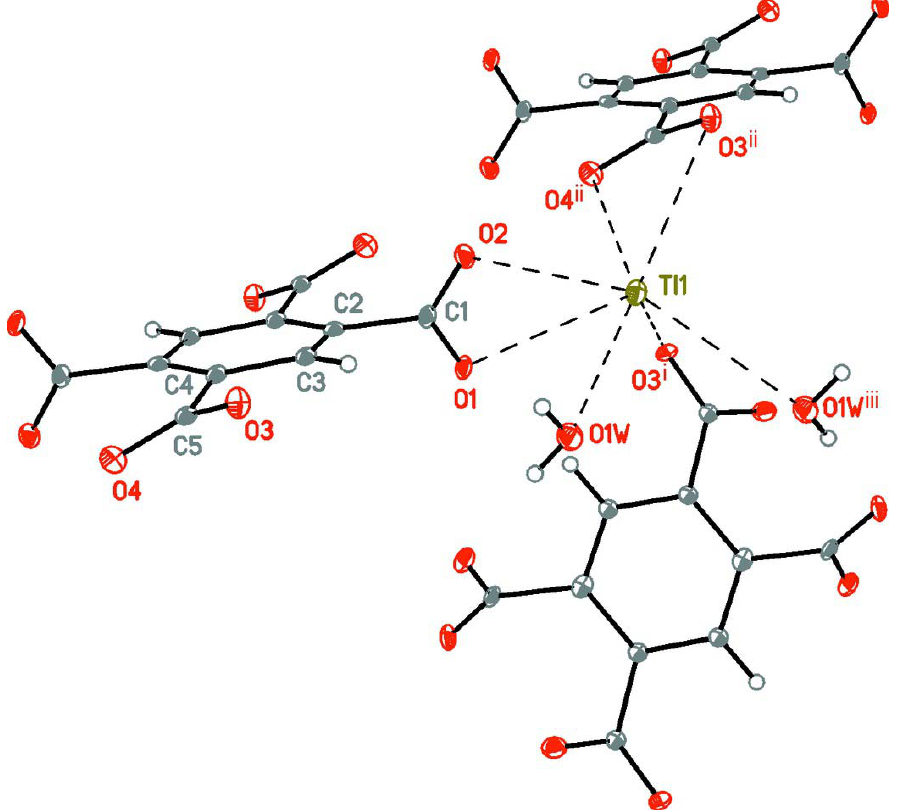
Coordination environment around the Tl atom in the title compound, showing an empty space on one side of the atom Tl1. Displacement ellipsoids are drawn at the 50% probability level. [Symmetry codes: (i) 1/2- x , -1/2+ y , 3/2- z ; (ii) -1+ x , y , z ; (iii) - x , - y , 1- z